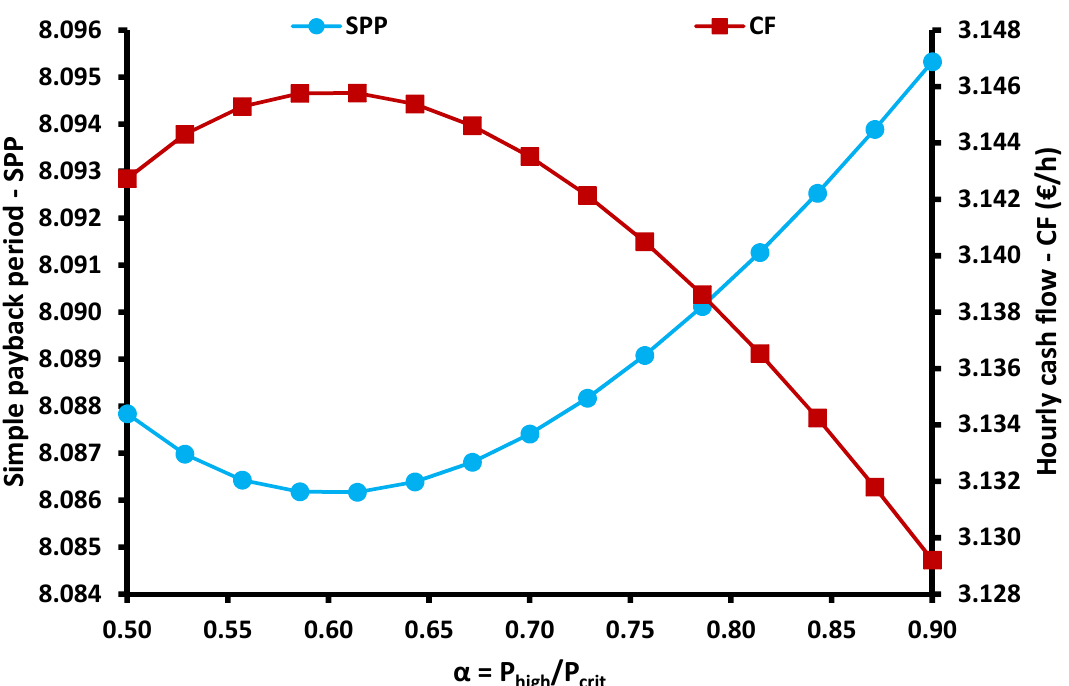
Figure 4. Simple payback period and hourly cash flow for different pressure ratio parameters.